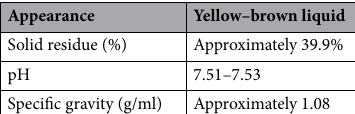
Table 2. Physical properties of polycarboxylate super plasticizer